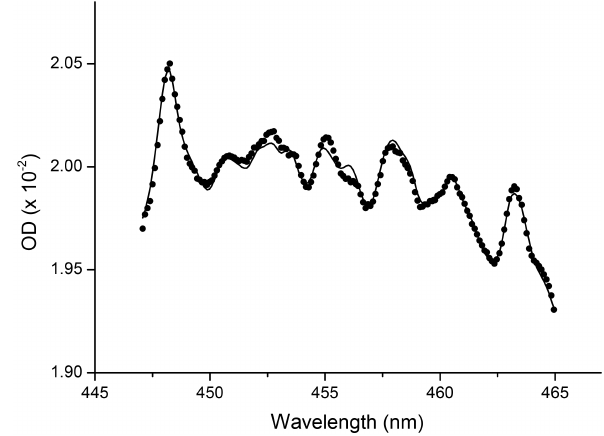
Figure 4. NO 2 impurity measurement (experiment at 298K, 18Torr) using the ternary mixture. The dotted line is the experi- mental NO 2 optical density (OD); the solid line is the fitted opti- cal density using a reference spectrum (Bogumil et al., 2003). In this measurement, the NO 2 impurity corresponded to 0.01% of the HNO 3